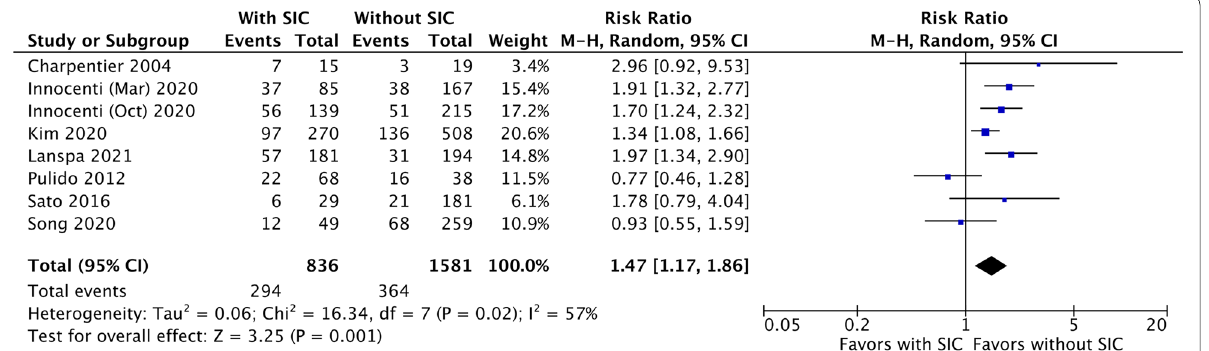
Fig. 3 The forest plot shows one‑month mortality between septic patients with and without sepsis‑induced cardiomyopathy (SIC). SIC is significantly related to higher risk of one‑month mortality among septic patients